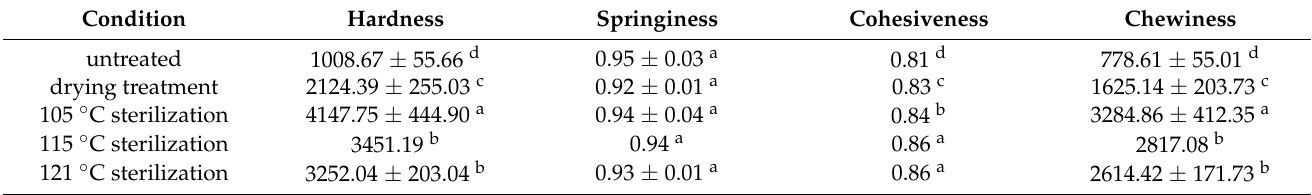
Table 1. Changes in the texture of tilapia fish cakes under different